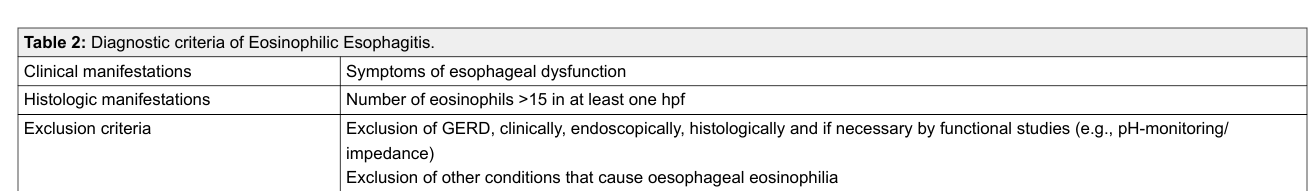
Table 2: Diagnostic criteria of Eosinophilic Esophagitis. Clinical manifestations Symptoms of esophageal dysfunction Histologic manifestations Exclusion